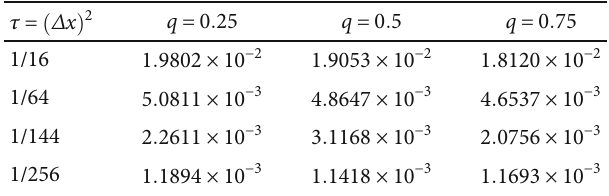
Table 1: The numerical results of the IDS for Example 6 at T = 1 : 0